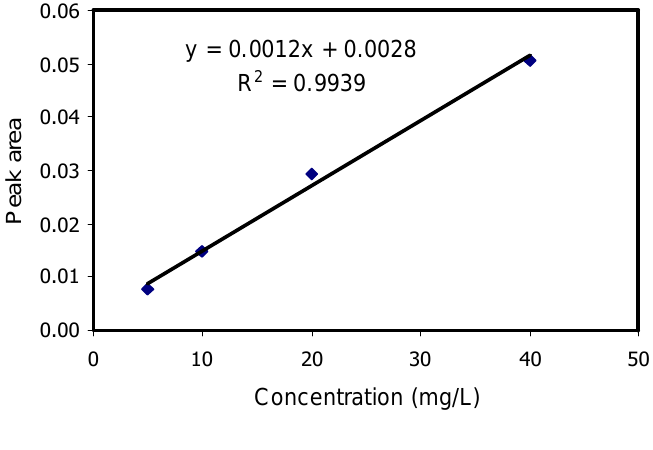
Figure 9. Acetone calibration curve in the 5-40 mg/L concentration range y = 0.0012x + 0.0028 R 2 =